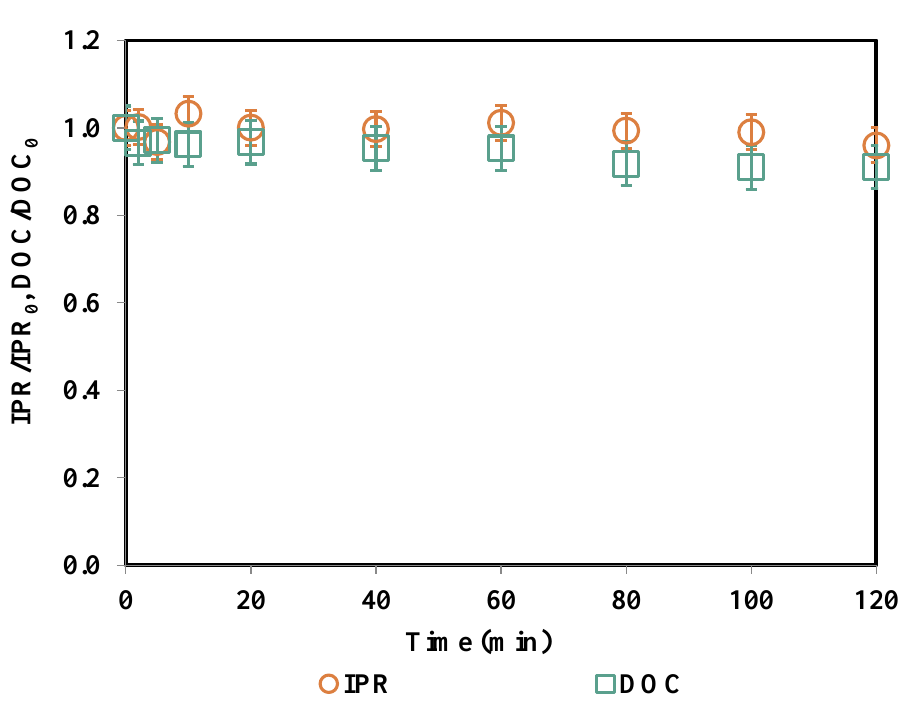
Figure 10. Changes in normalized IPR and DOC during ZVA/PS treatments in SWW. IPR = 2 mg/L; DOC = 11.96 mg/L; PS = 1.50 mM; ZVA = 1 g/L, pH = 3.0.